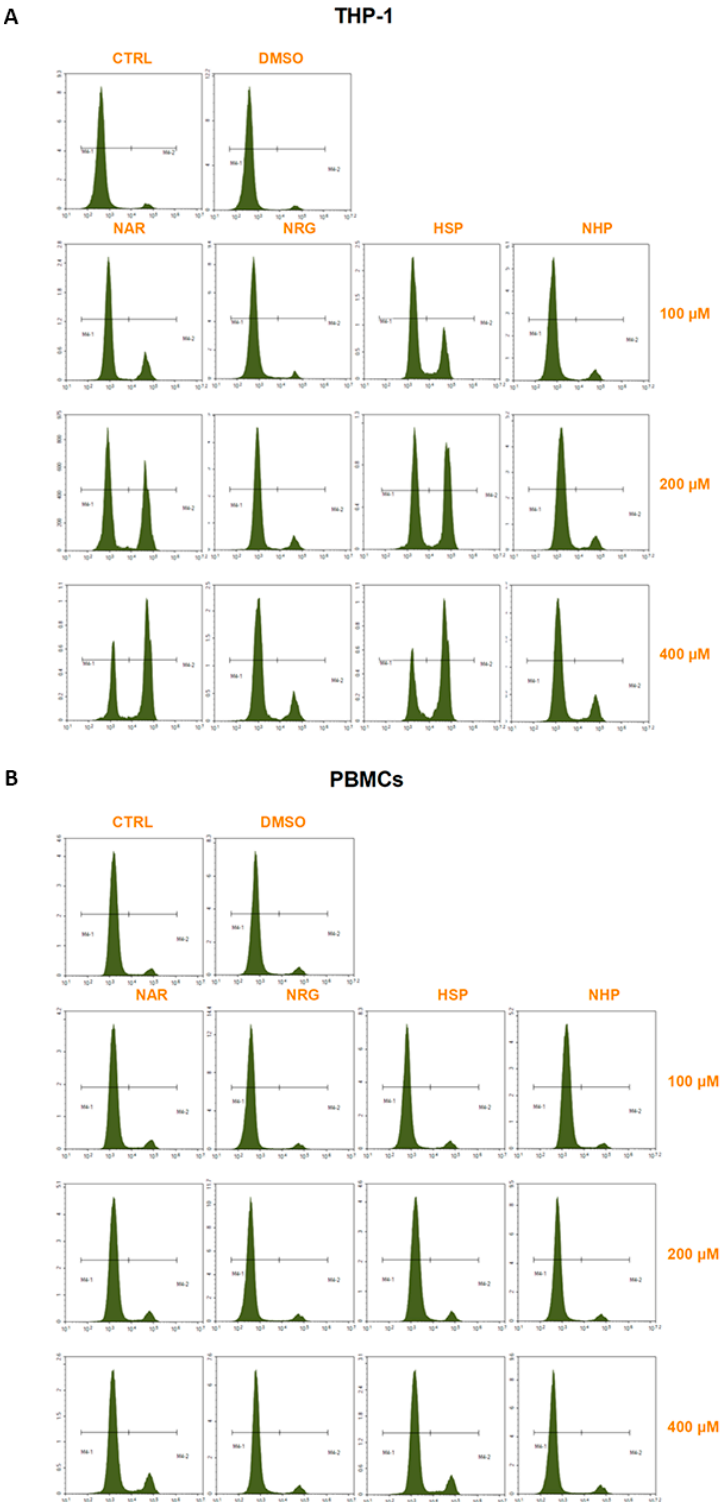
Figure 5. Cytotoxic effects of NAR, NRG, HSP, and NHP (100–400 µM) in THP-1 ( A ) and PBMCs ( B ) cells after 72 h of exposure, assessed by PI staining. Plots are representative of three different experimental sessions of PI staining performed in triplicate ( n = 9). * p < 0.05, ** p < 0.01, and *** p < 0.001 vs. CTRL.